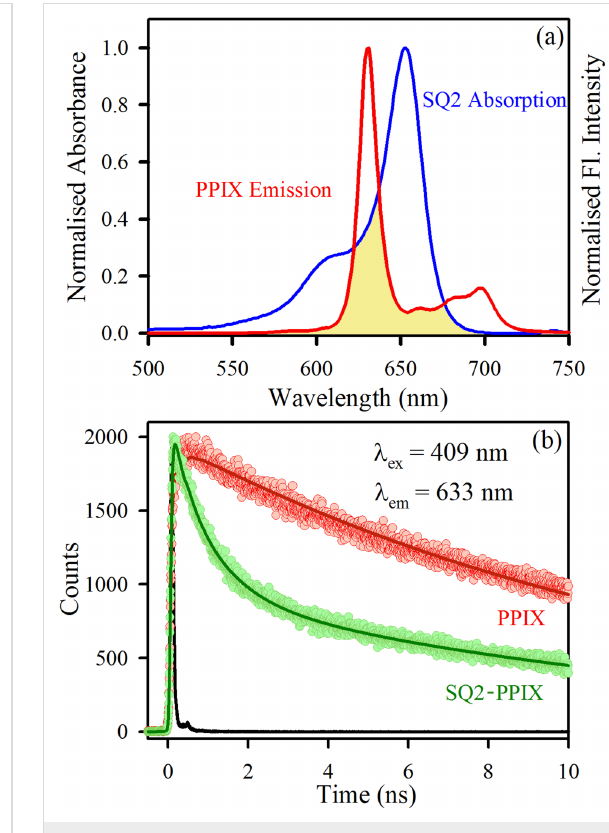
Figure 2: (a) Spectral overlap between the emission of PPIX and the absorption of SQ2, (b) The picosecond-resolved fluorescence decays of PPIX attached to Al 2 O 3 in absence (red) and presence (green) of